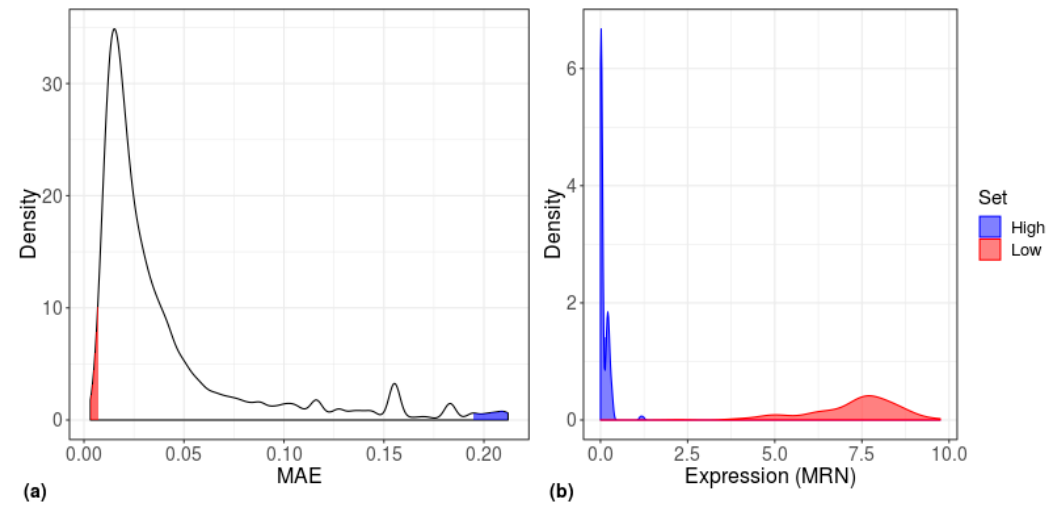
Figure 8. Distribution of gene-centered MAE scores for human embryonic stem cells (H1). ( a ) Density plot of MAE scores, calculated separately for each gene ( n = 19,097 genes) across all H1 cells ( n = 375 cells). ( b ) Density plot of the expression values of the highest (blue) and lowest (red) MAE genes of the H1 cells.